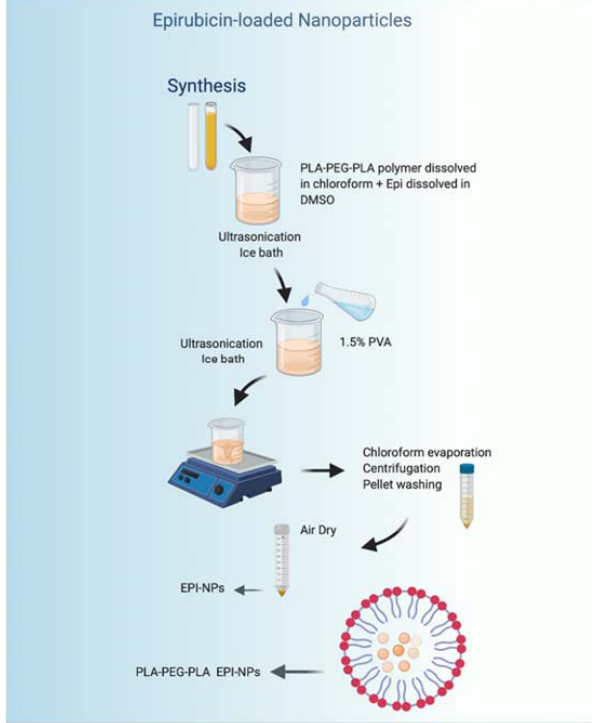
Figure 1. Schematic presentation representing the double emulsion method used to synthesize the epirubicin-loaded polymeric nanoparticles (EPI-NPs). PLA–PEG–PLA: poly (lactide) poly (ethylene glycol) poly(lactide); DMSO: dimethyl sulfoxide; PVA: poly (vinyl alcohol).